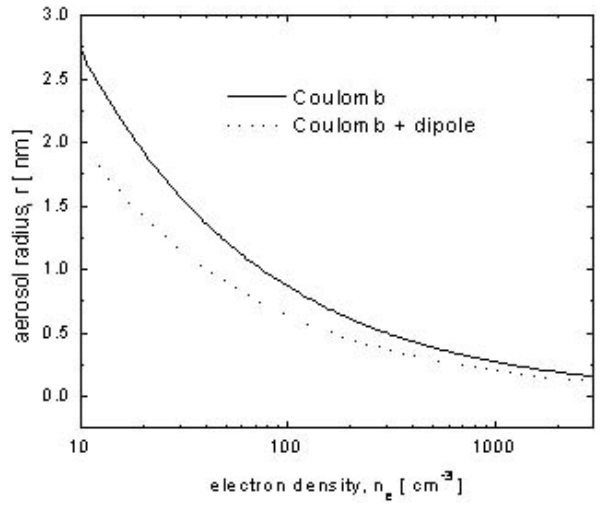
Fig. 11. The size of the positive aerosol particle when it is neutral- ized by capturing an electron as a function of electron density. The solid line for a charging model with only the Coulomb force and the dotted line is for a model with both the Coulomb force and the dipole